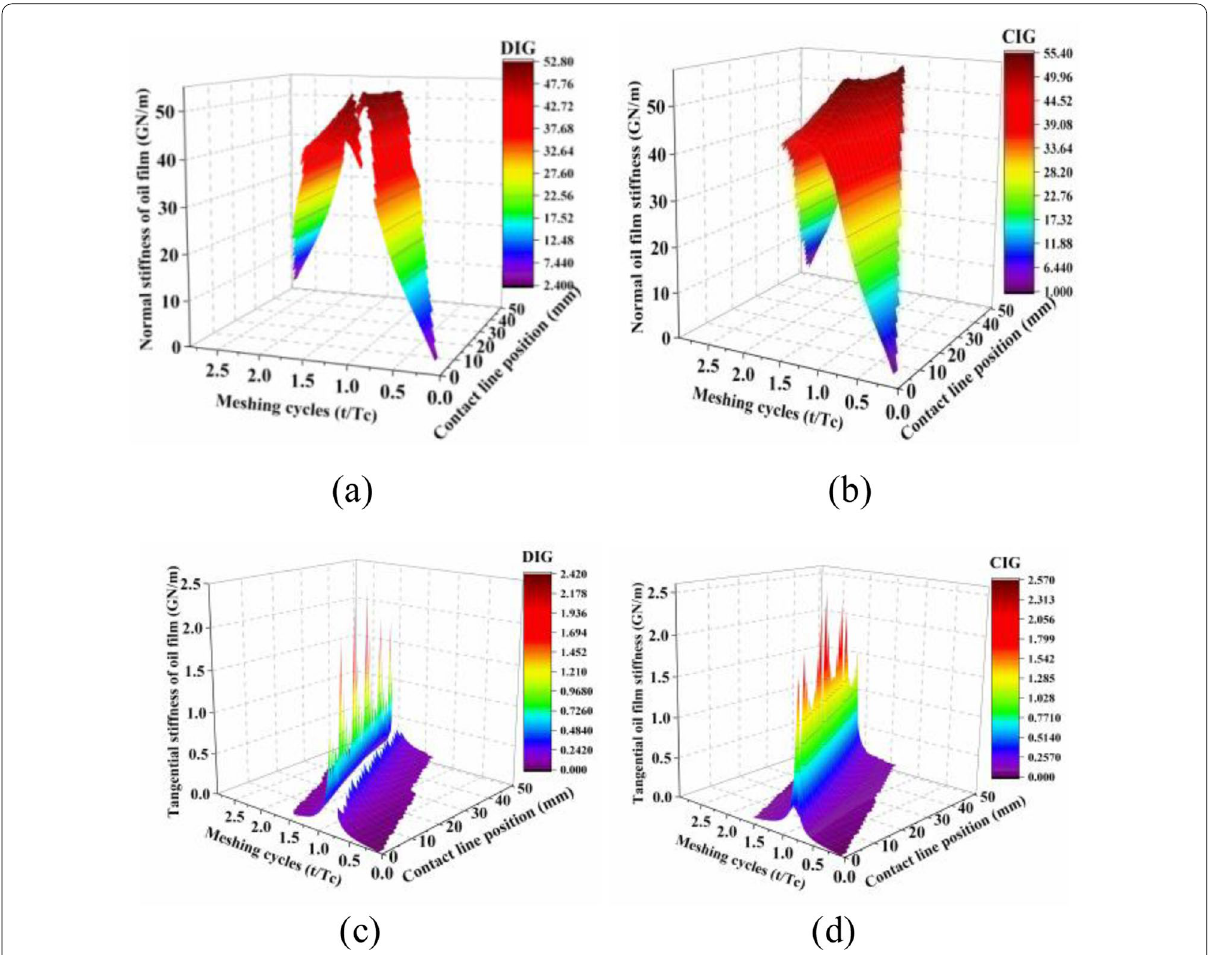
Figure 11 Comparision of the oil film stiffness between DIG and